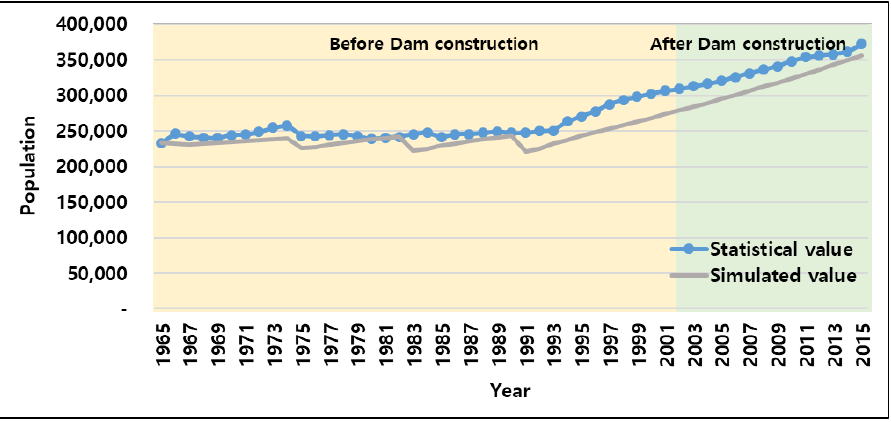
Figure 6. Calibration results—population.